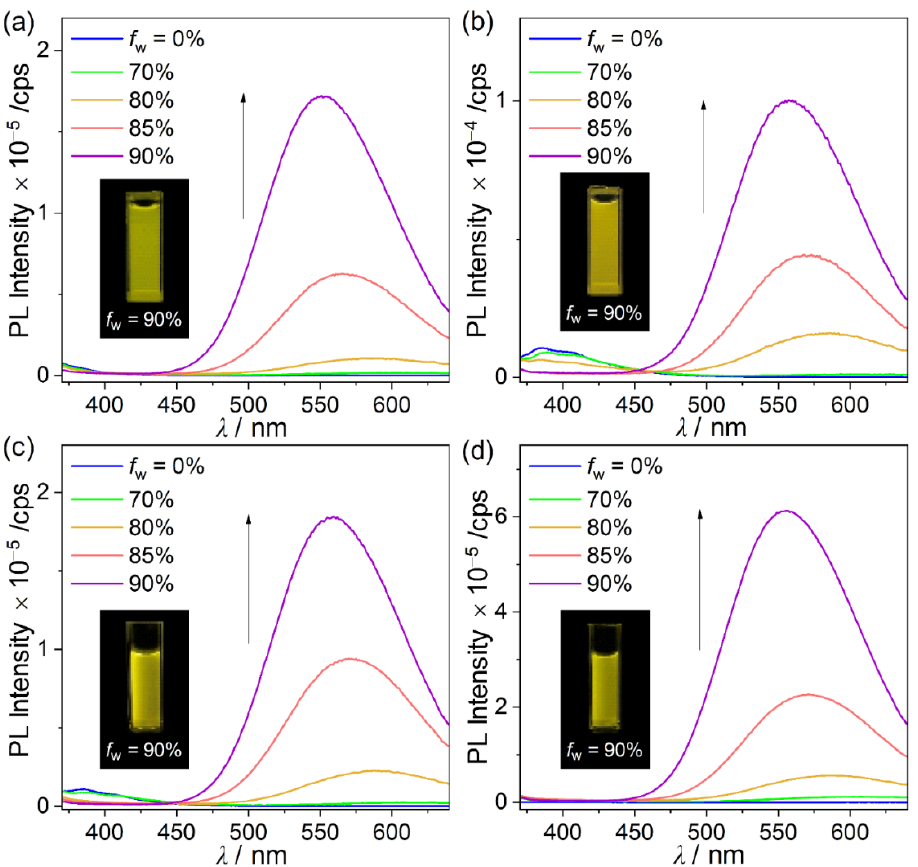
Figure 5. PL spectra of ( a ) 1F (λ ex = 329 nm), ( b ) 2P (λ ex = 328 nm), ( c ) 3M (λ ex = 330 nm), and ( d ) 4T (λ ex = 333 nm) in THF/water mixtures (30 µM). Insets: emission color at f w = 90% under irradiation by a hand-held UV lamp (λ ex = 365 nm).